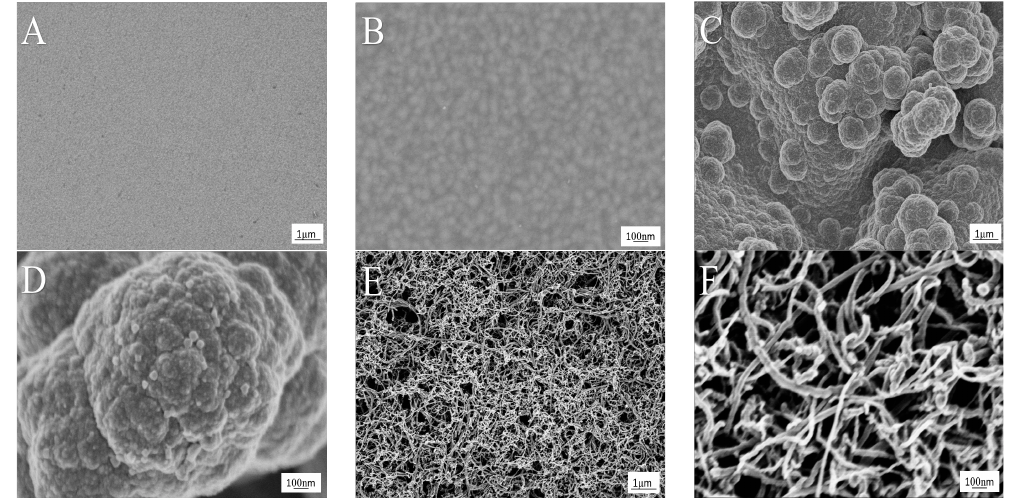
Figure 2. SEM images of ( A , B ) bare Au; ( C , D ) polypyrrole (PPy)/Au; ( E , F ) PPy/MWCNT/Au (MWCNTs: multiwalled carbon nanotubes). The magnifications are (A,C,E) 10 k; and (B,D,F) 60 k.